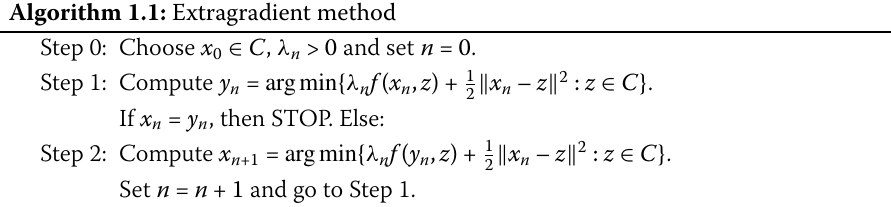
Algorithm 1.1: Extragradient